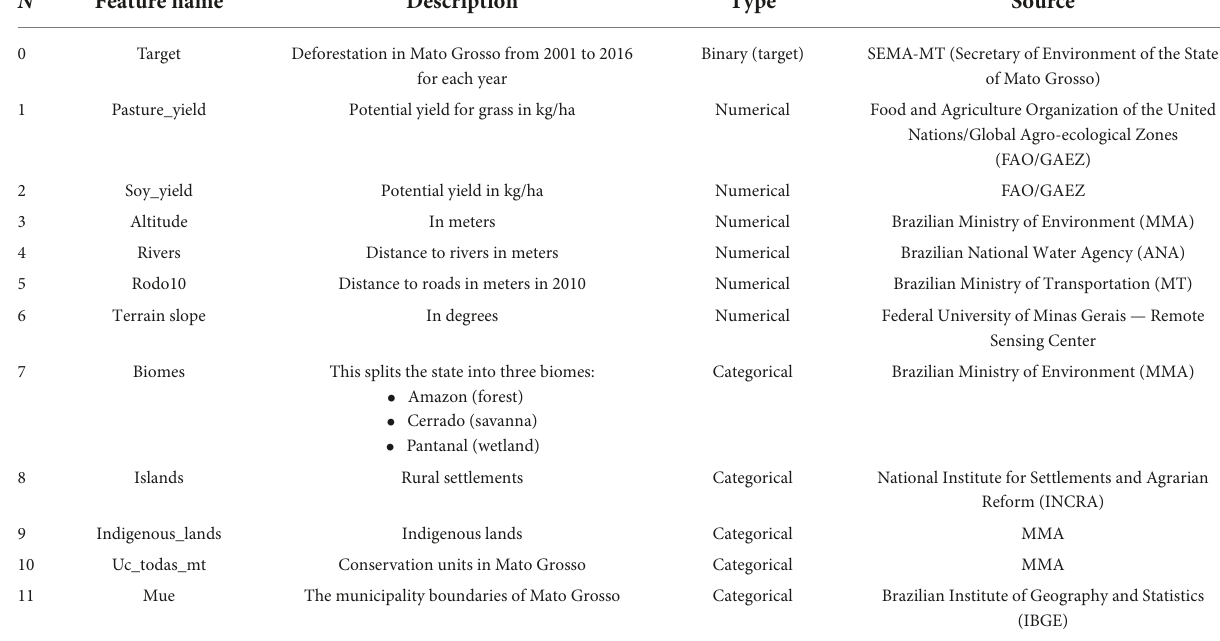
TABLE 1 Features and variables used in the